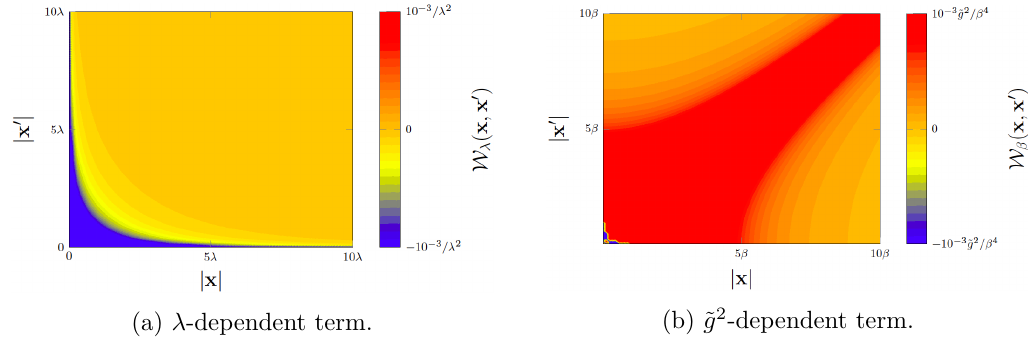
Figure 5 : The equal-time t = t 0 limits of the λ -dependent term and ˜ g 2 -dependent term of the Wightman function given in eq. (3.11). (Colour